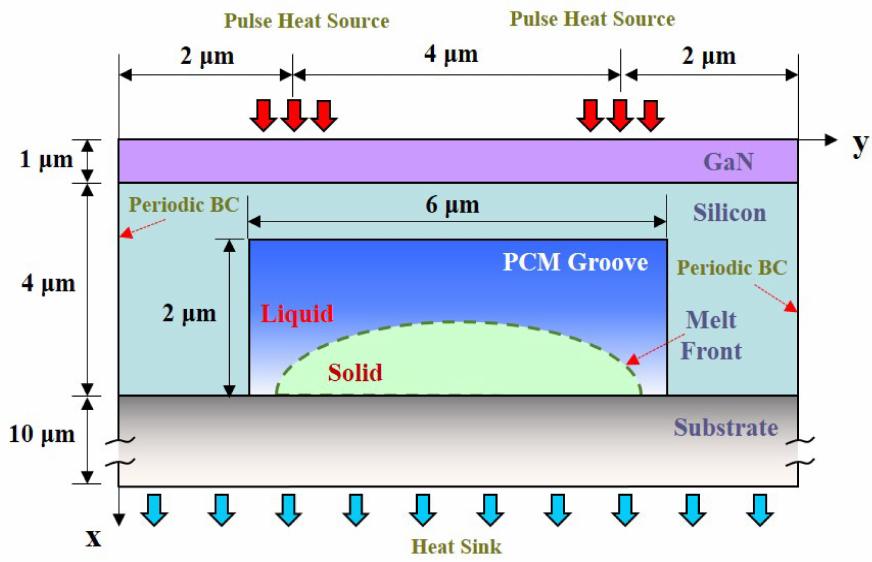
Figure 17. Schematic of the thermal model of a transistor unit with a microscale PCM groove